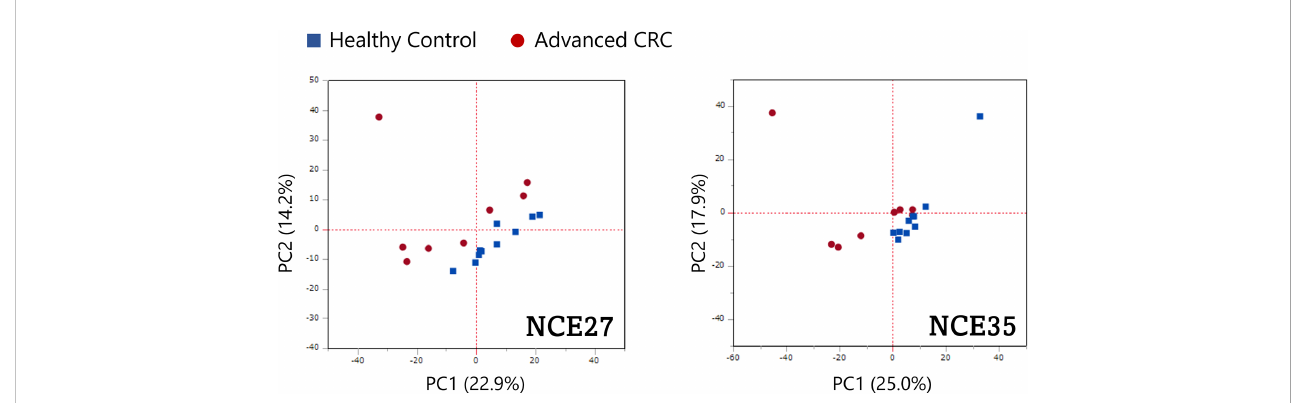
FIGURE 3 Potential ability of O-glycoproteins to distinguish patients with advanced CRC from healthy individuals. Principal component analysis (PCA) was performed on the peak area of the O-glycoforms.